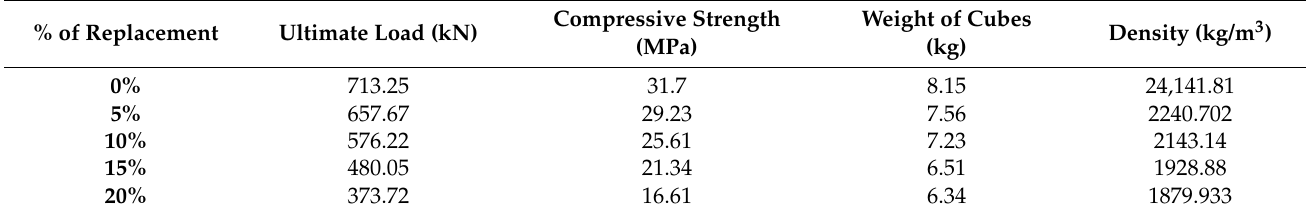
Table 3. Compressive strength and density of concrete [32]. Copyright© 2017, Elsevier